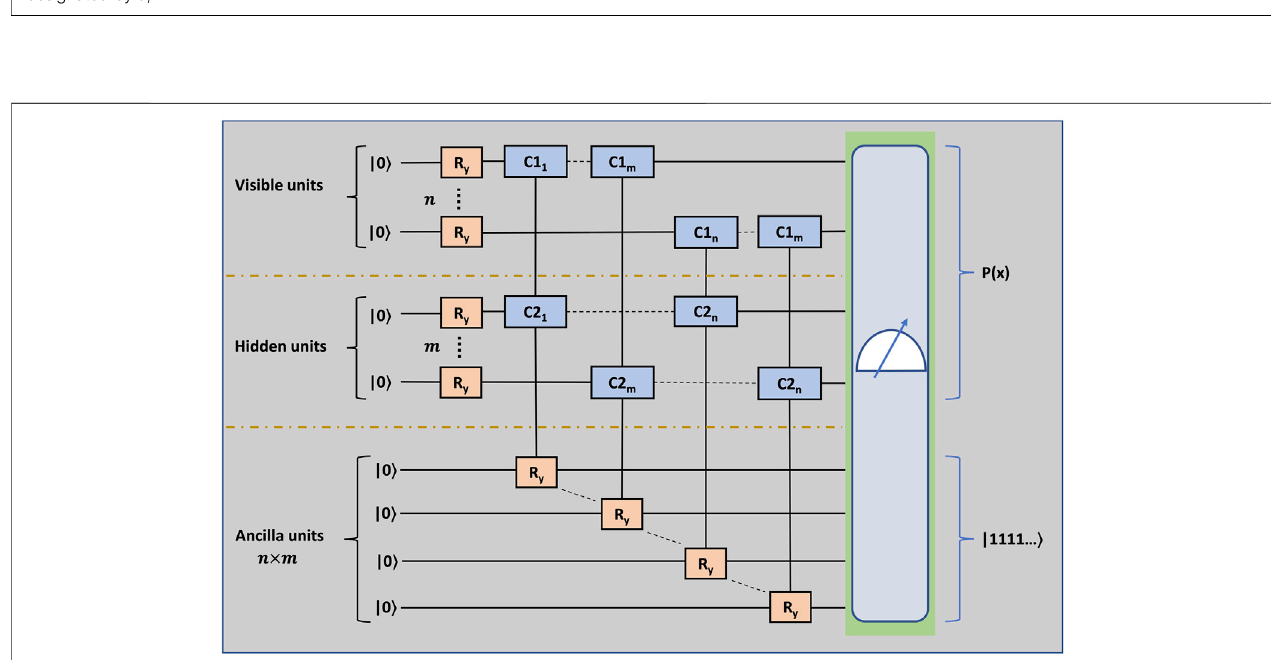
FIGURE3| ThequantumcircuittosampletheGibbsdistribution. n isthenumberofqubitsbelongingtothevisiblelayerand m isthenumberofqubitsbelongingto the hidden layer. There are m × n ancillary qubits.